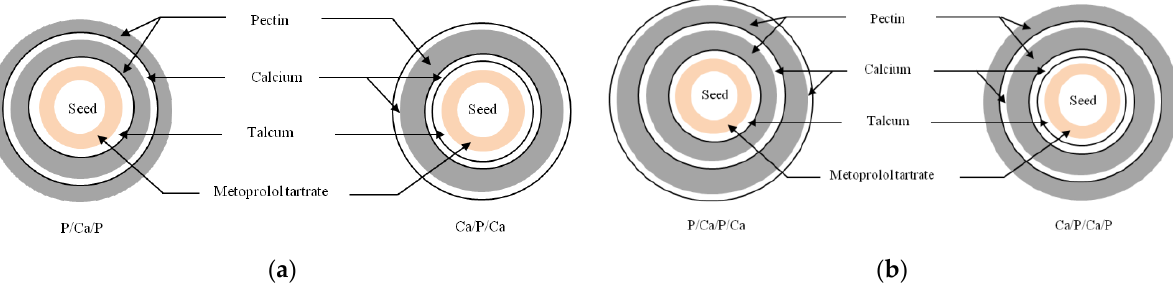
Figure 2. Illustration of alternate coated pellets with ( a ) coating sequence III, 3-layer coating; ( b ) coating sequence VI, 4-layer coating.